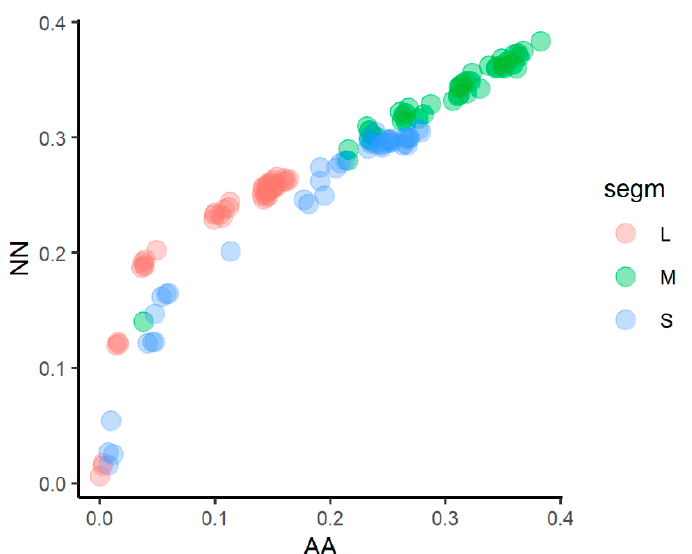
Figure 2. Nucleotide and amino acid uncorrected p-distance between viruses of the Salehabad complex.